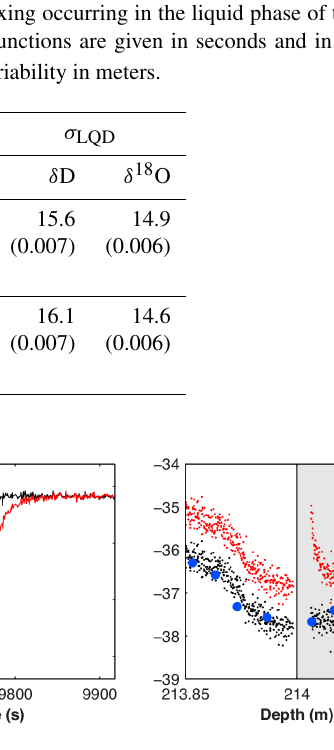
Figure 6. Mixing corrections for mock ice (left) and the beginning of an ice core section (right). The ice core mixing correction is based upon a known step-function change defined by the mock ice, from which mixing coefficients are determined. Red represents raw un- corrected isotopic data with no memory correction, black represents VSMOW corrected data with the memory correction applied, blue dots represent 3cm IRMS discrete samples, and the grey region rep- resents the depth range of corrected data that would otherwise be discarded. Note that the time variable represents the amount of run time on a given